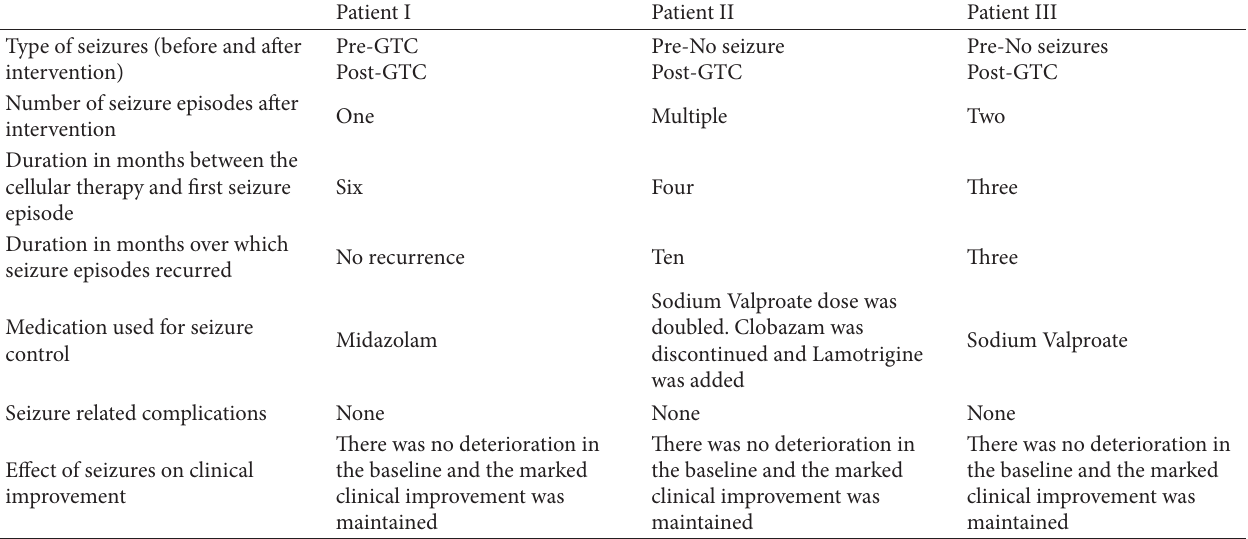
Table 5: Details of three patients who had seizures as an adverse event after cellular therapy. Patient I Patient